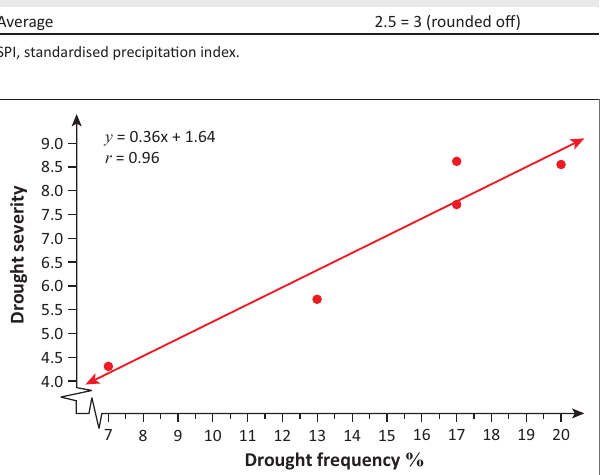
FIGURE 7: Scatter plot of drought severity against drought frequency.